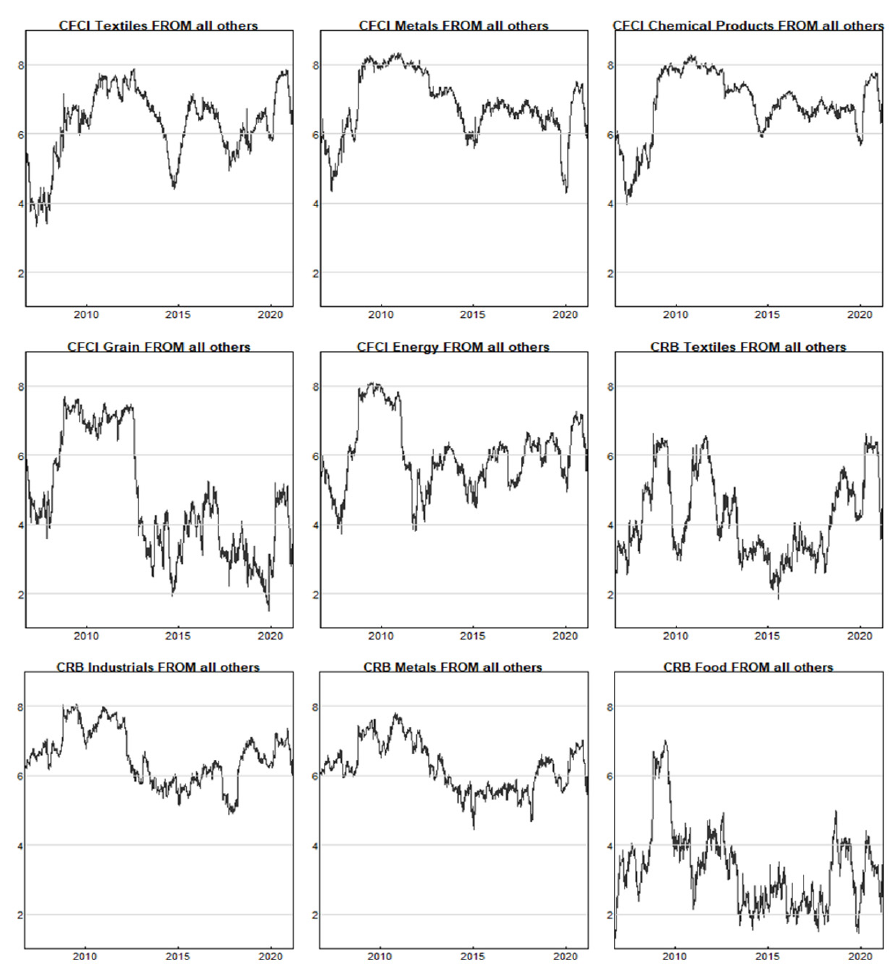
Figure 3. The “IN” directional volatility spillover diagram of rolling samples.